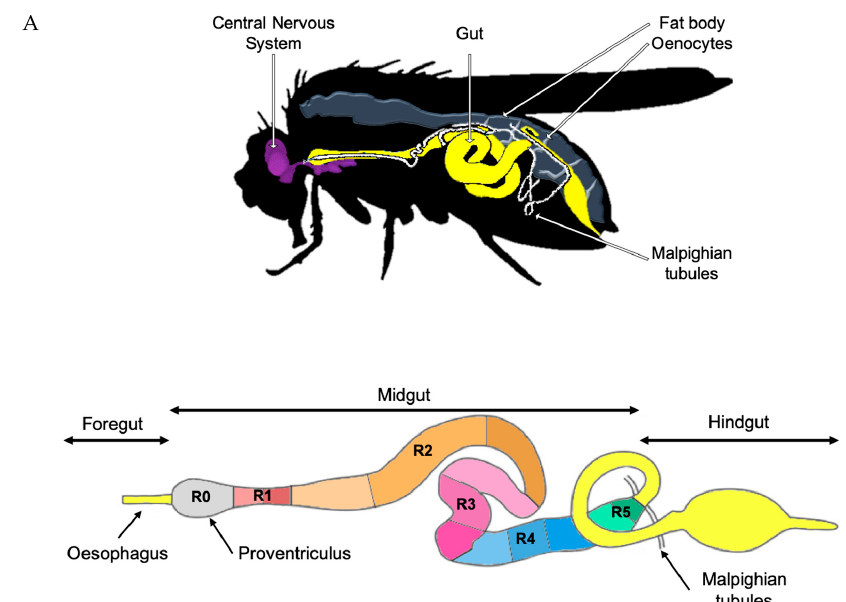
Figure 1. Adult Drosophila melanogaster anatomy. ( A ) The Drosophila melanogaster model system contains tissues that functionally correspond to most essential human organs: central nervous system, gastrointestinal system, adipose tissue and the liver (synergic function of fat body and oenocytes) and kidneys (Malpighian tubules). ( B ) The Drosophila melanogaster adult foregut, midgut, and hindgut. The midgut consists of six major anatomical regions (R0–R5) which are further subdivided into 14 color-coded sub-regions (for example, R2 is subdivided into three orange sub-regions) according to morphometric, histochemical and transcriptomic data.